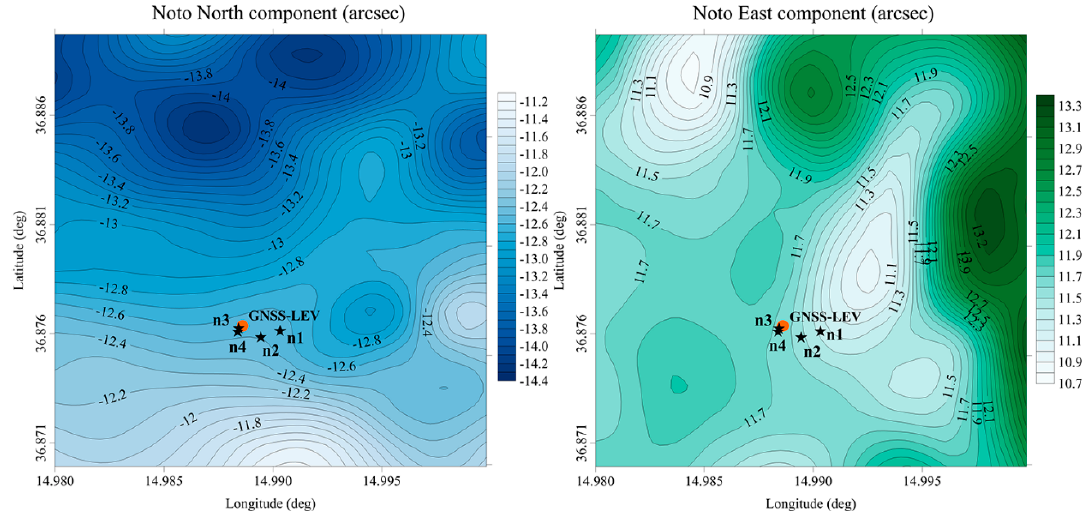
Figure 6. DoV components ξ (North) and η (East) calculated from the ITALGEO2005 grid at Noto site. The orange dots indicate the point for which the DoV was estimated using the GNSS-LEV method; the black stars identify the locations where the DoV was measured using QDaedalus.